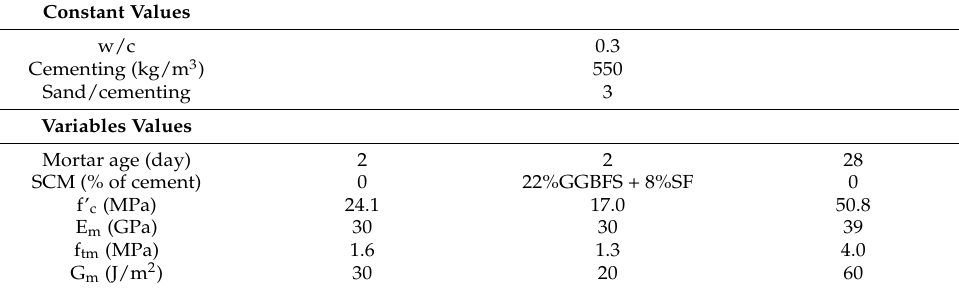
Table 4. Mortar mixture composition and